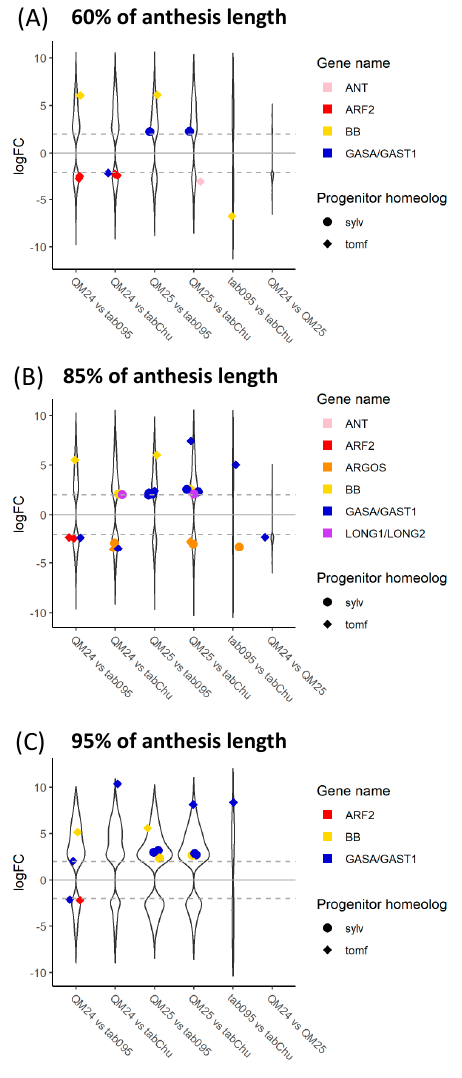
Figure 6. Log 2 fold change of di ff erentially expressed genes across comparisons between natural and synthetic N. tabacum accessions at ( A ) 60%, ( B ) 85%, and ( C ) 95%of anthesis length: violin plots represent all di ff erentially expressed genes between each comparison, whereas colorful strip plots represent di ff erentially expressed candidate floral organ size genes. Positive logFC values represent genes upregulated in the first accession listed in the comparison, whereas negative logFC values represent genes upregulated in the second accession listed. The dashed gray lines across the plot denote the log 2 = | 2 | cuto ff for di ff erentially expressed genes. Sylv = N. sylvestris , tomf = N. tomentosiformis , tab095 = N. tabacum 095-55, tabChu = N. tabacum ‘Chulumani’, QM24 = synthetic N. tabacum QM24, and QM25 = synthetic N. tabacum